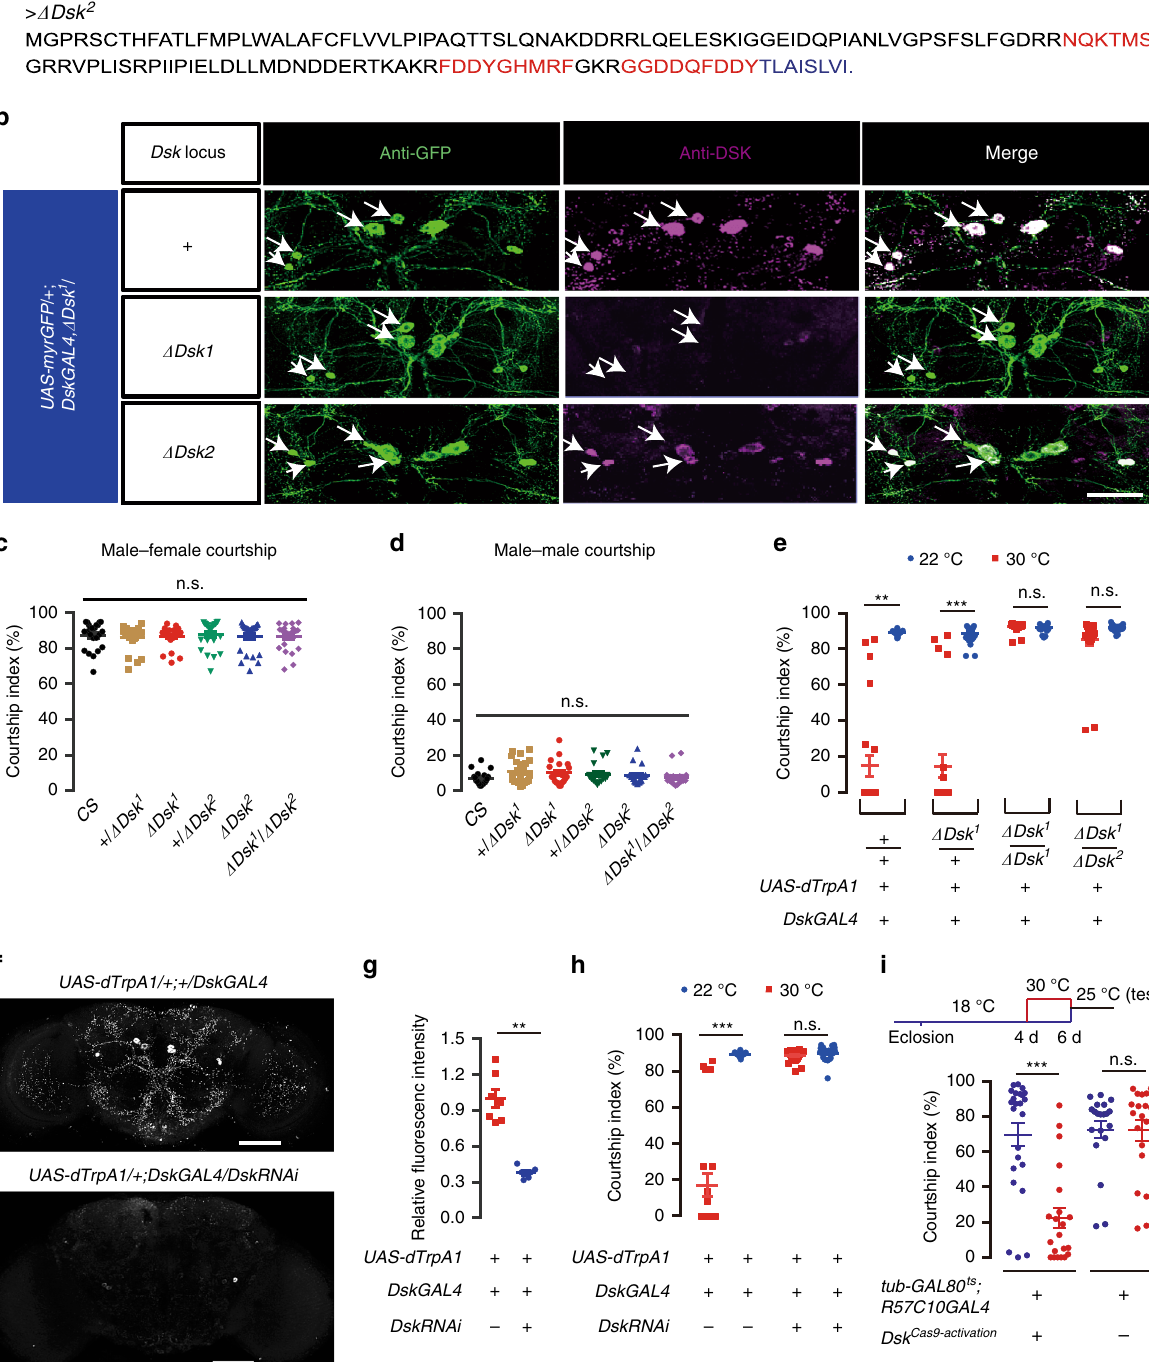
males (11 males, the same as used in Fig. 5i), and found no difference of male courtship in wild-type control males and Dsk knocked-down males ( R57C10GAL4/UAS-DskRNAi ) (Supple- mentary Fig. 8a). We then repeated male courtship, but tested in restricted conditions (headless females as targets under